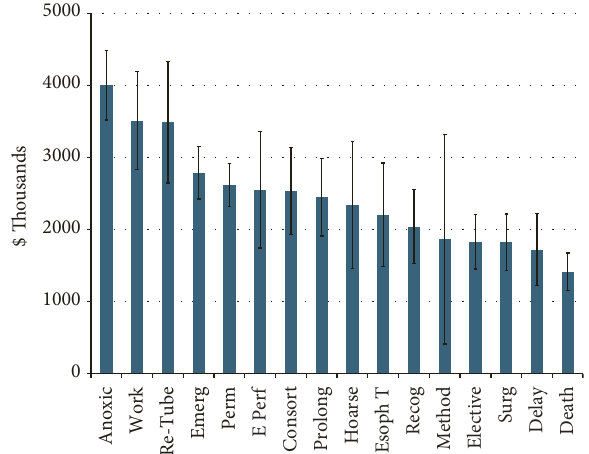
Figure 5: Most cited factors in malpractice litigation. Perm � permanent injury, Emerg � emergent intubation, Anox- ic � anoxic brain injury, Consort � loss of consortium, Surg � required reparative surgery, Work � employment/income affected, Prolong � prolonged intubation, Delay � delayed intuba- tion, Esoph T � esophageal intubation, Re-tube � reintubation, Recog � delayed recognition of complication, Hoarse � hoarseness, Method � other method should have been used, IC � perceived deficit in informed consent, Trauma � traumatic intubation, Incorrect � “incorrect intubation” (unspecified), Asp � aspiration, Fail � failed intubation, Early � premature extubation, Hx � ne- glected medical history, Unn. � unnecessary intubation, TS � tra- cheal stenosis, Teeth � injury to teeth, E Perf � esophageal perforation, VC � vocal cord injury, Displaced � displaced endo- tracheal tube, Size � incorrect ET tube size, Self-Ext. � self-extu- bation by